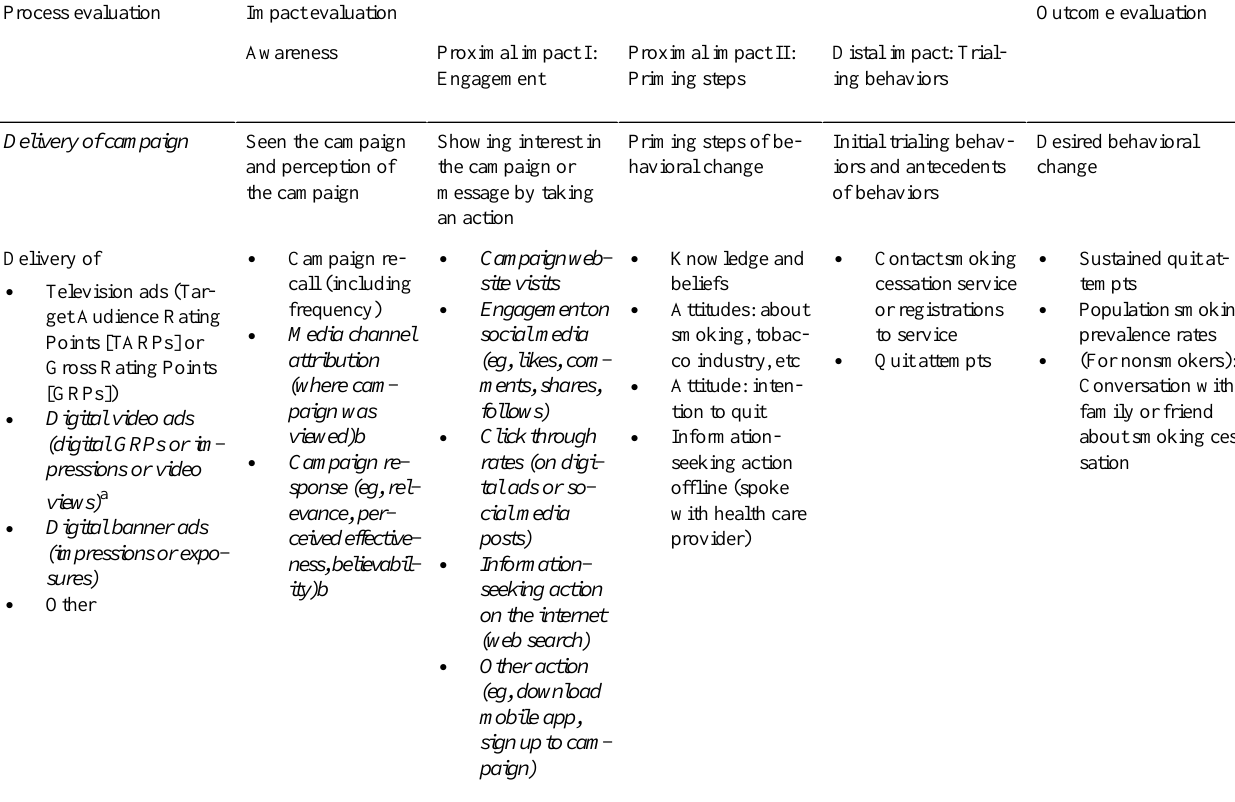
Table 1. Conceptual framework of campaign evaluation metrics and